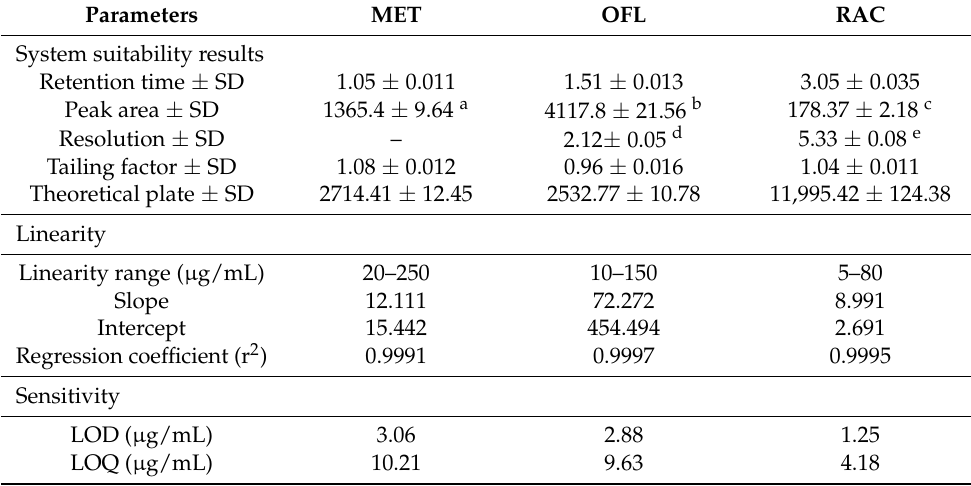
Table 1. System suitability and regression analysis